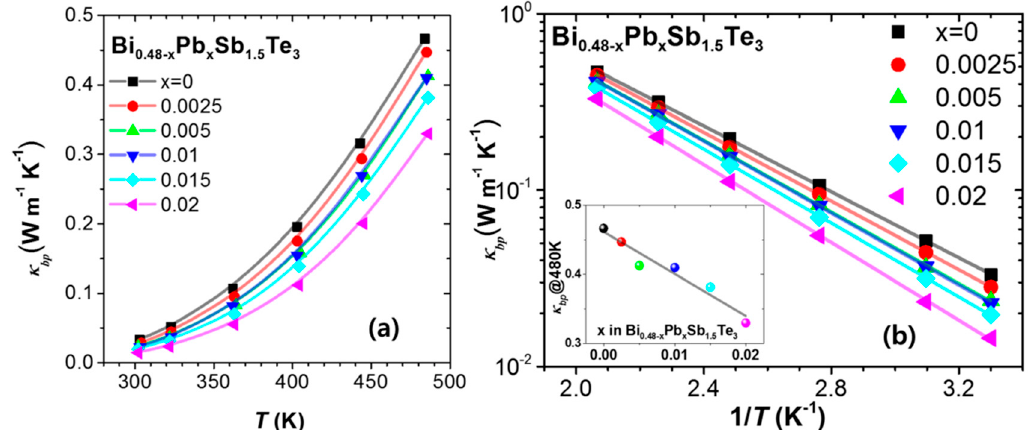
Figure 4. ( a ) Temperature dependence of bipolar thermal conductivity, κ bp , of Bi 0.48- x Pb x Sb 1.52 Te 3 ( x = 0, 0.0025, 0.005, 0.01, 0.015, and 0.02) estimated from the two-parabolic band model [10]; ( b ) ln( κ bp ) vs. (1/ T ). Inset shows that the κ bp at 480 K decreases as the Pb substitution increases.